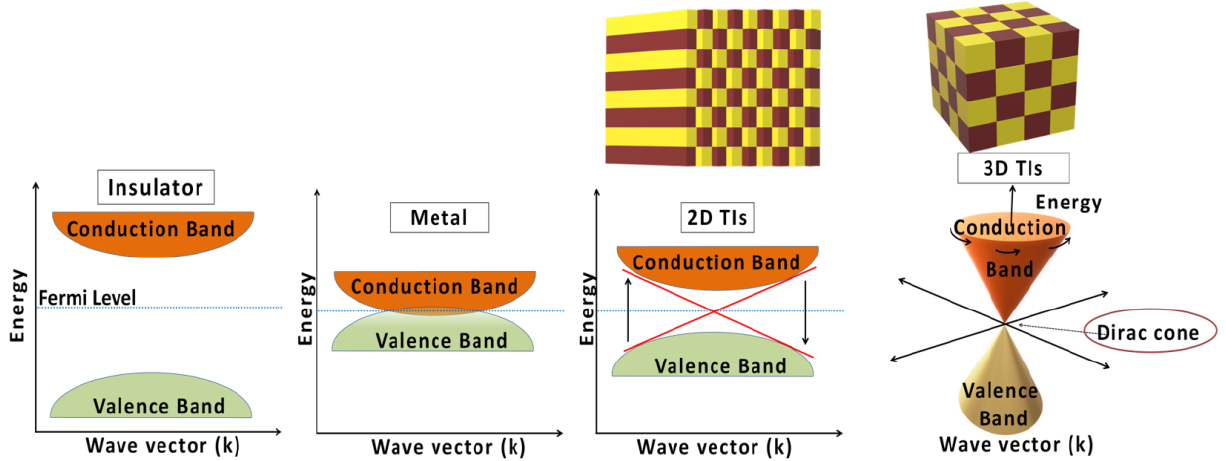
Figure 1. Energy Band diagram for insulator, metal, 2D TIs, and 3D TIs.